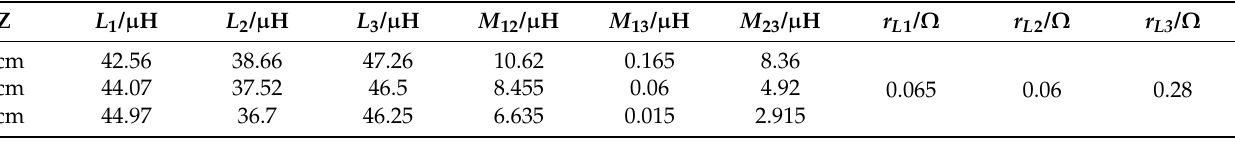
Table 3. Measured parameters of the magnetic coupler.